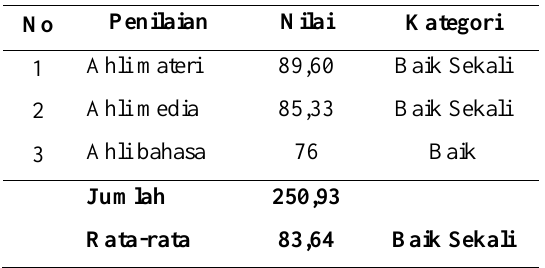
Tabel 4. Data Kuantitatif Hasil Uji